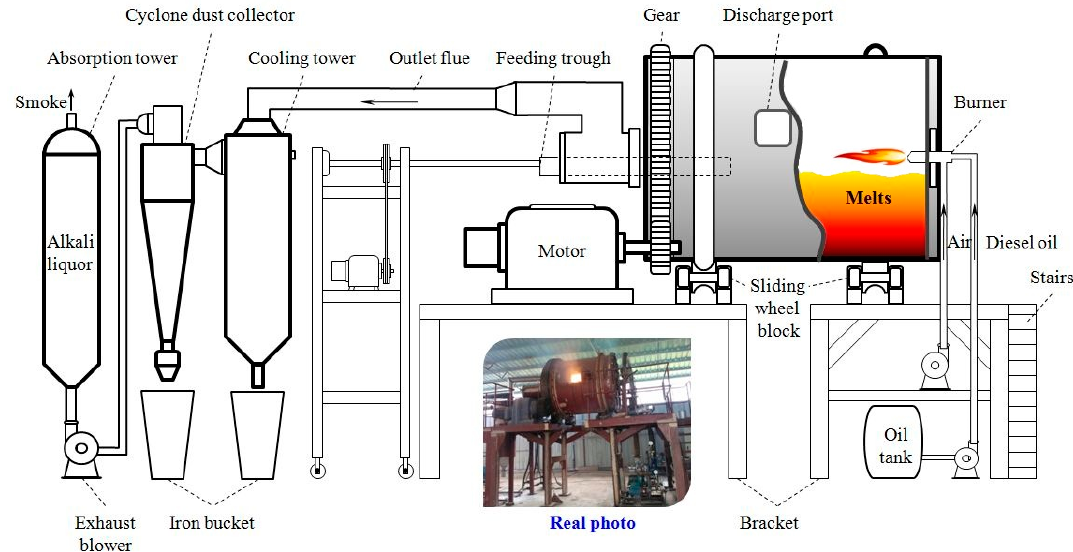
Figure 2. Rotary kiln and accessories for kilogram-class pilot experiments.